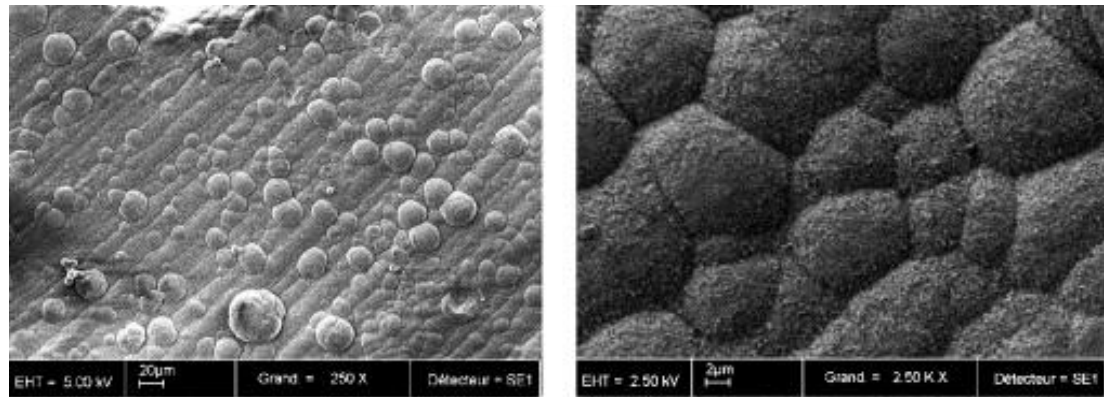
Figure 8. SEM micrographs of biomimetic calcium phosphate coating. Magnification: 250 × (left) and 2500 × (right) (reprinted from ref. [74] with permission).